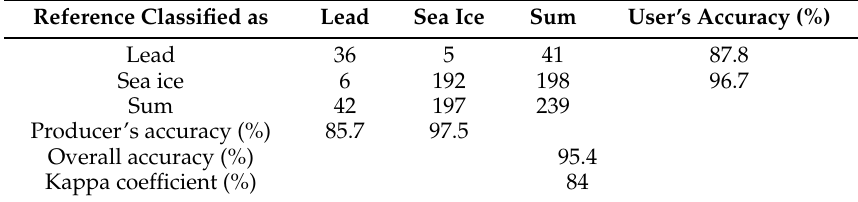
Table 7. The error matrix based on the See 5.0-based lead detection results for IC.